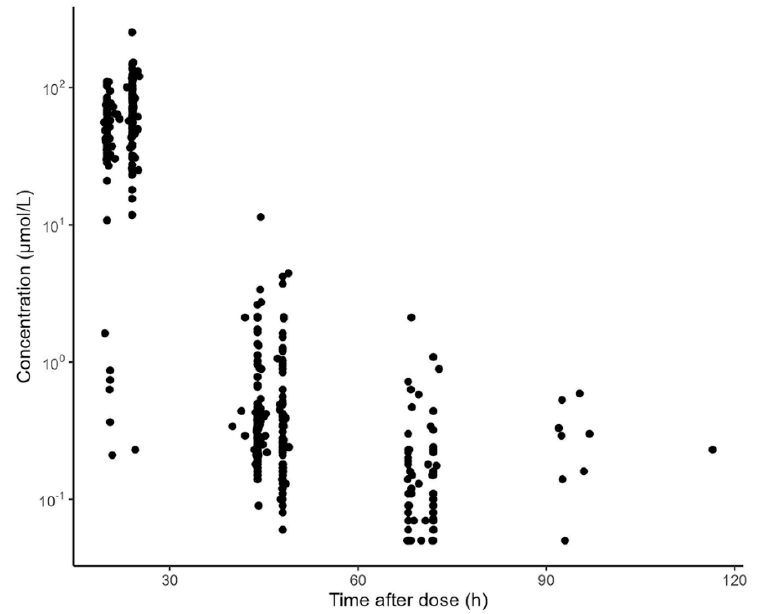
Figure 1. Methotrexate concentration versus time after dosing obtained with data available for external validation of the identified models.